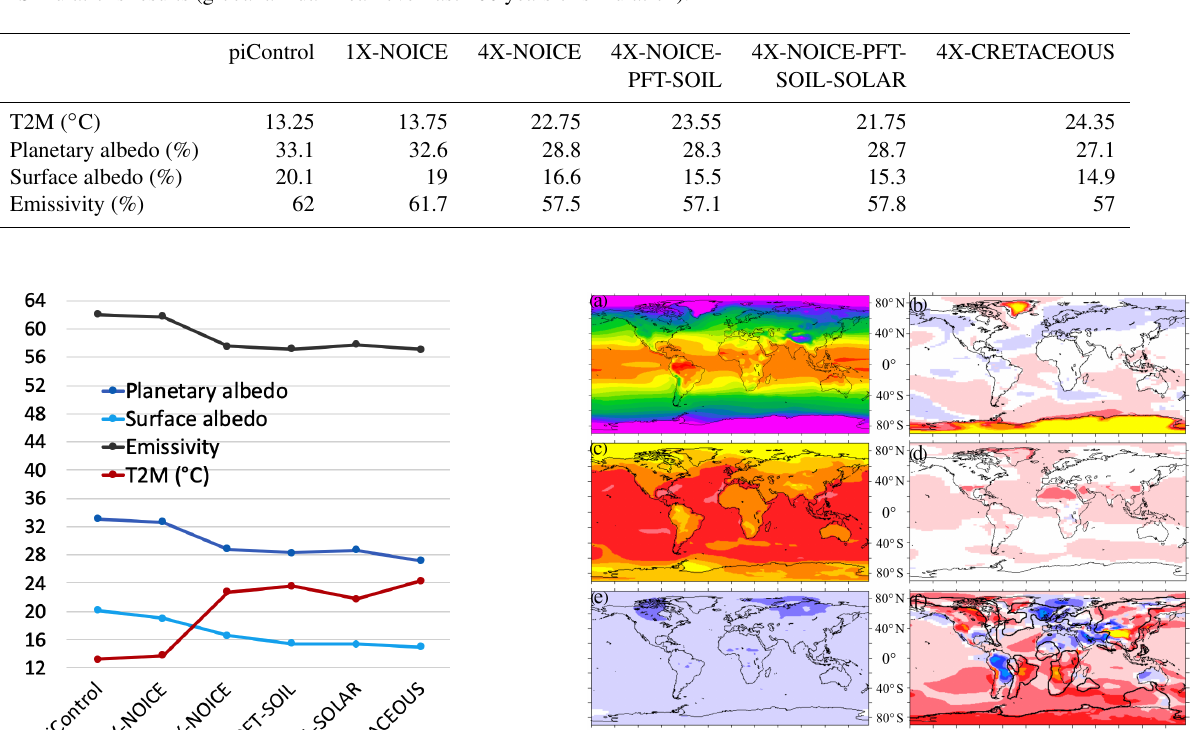
Table 2. Simulations results (global annual mean over last 100 years of simulation).